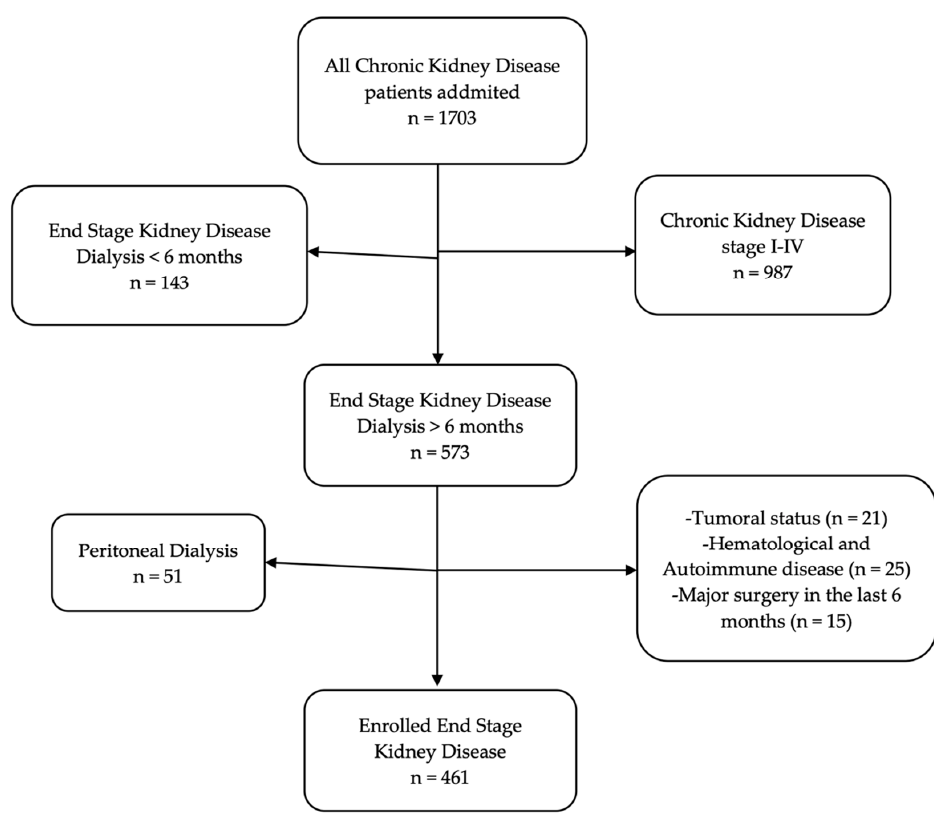
Figure 1. Enrollment flowchart. Table 1. Demographic, comorbidities, risk factors, type of dialysis access, and outcome of all patients included in the